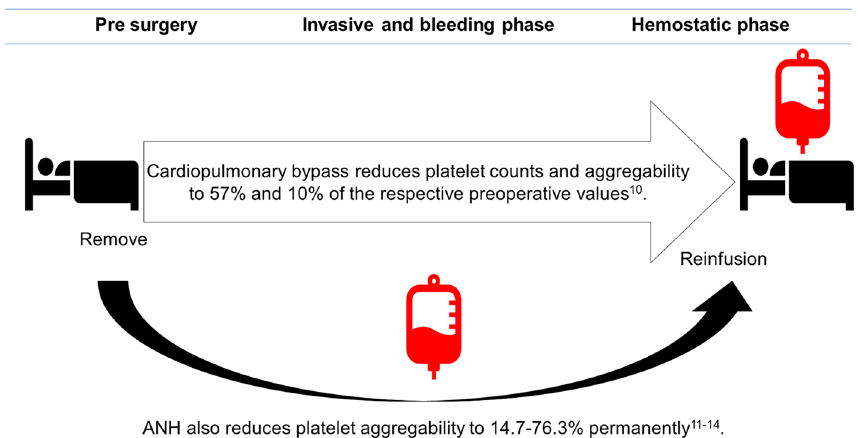
Figure 1. The conventional method of ANH cannot maintain platelet function. Cardiopulmonary bypass reduces platelet counts and function decreases to 57% and 10% of the respective preoperative values 10 . ANH also markedly reduces platelet function and these changes do not recover after transfusion 11–14 . This figure was drawn using Microsoft PowerPoint 2016 (Ver. 2103, https:// www. micro soft. com/ ja- jp/ micro soft- 365/ power point).